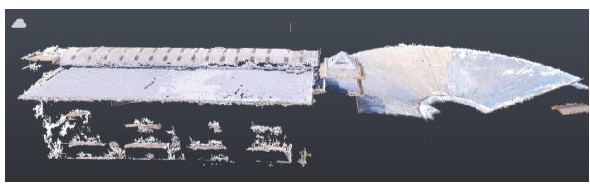
Figure 11 Orthophoto of the study area